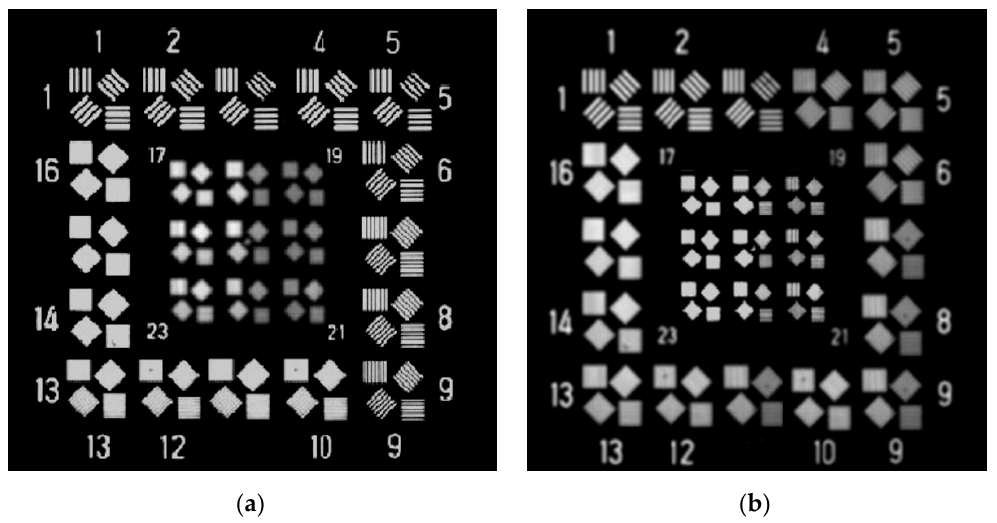
Figure 3. Images obtained at different temperatures: ( a ) at the initial temperature; ( b ) at a cold temperature after 1 h.